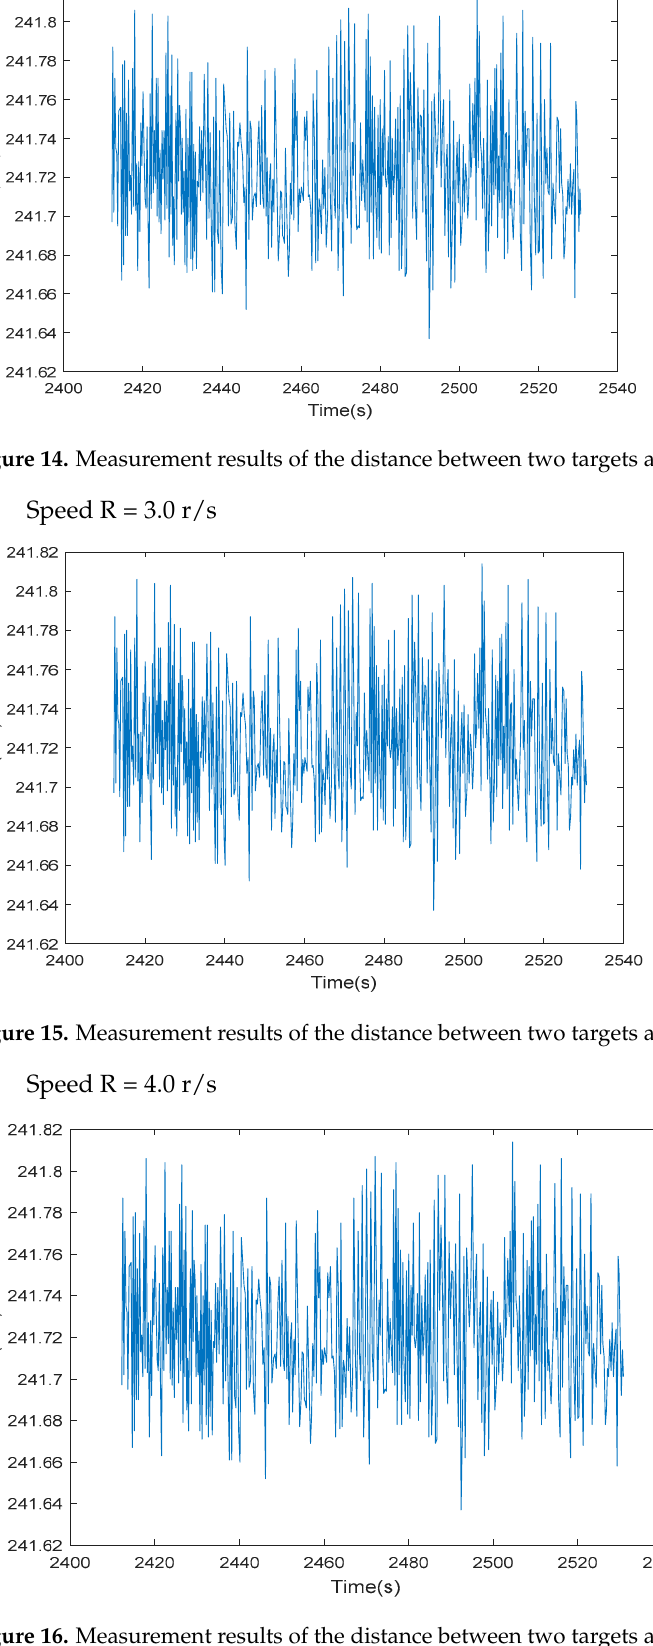
Figure 16. Measurement results of the distance between two targets at 4 r/s.